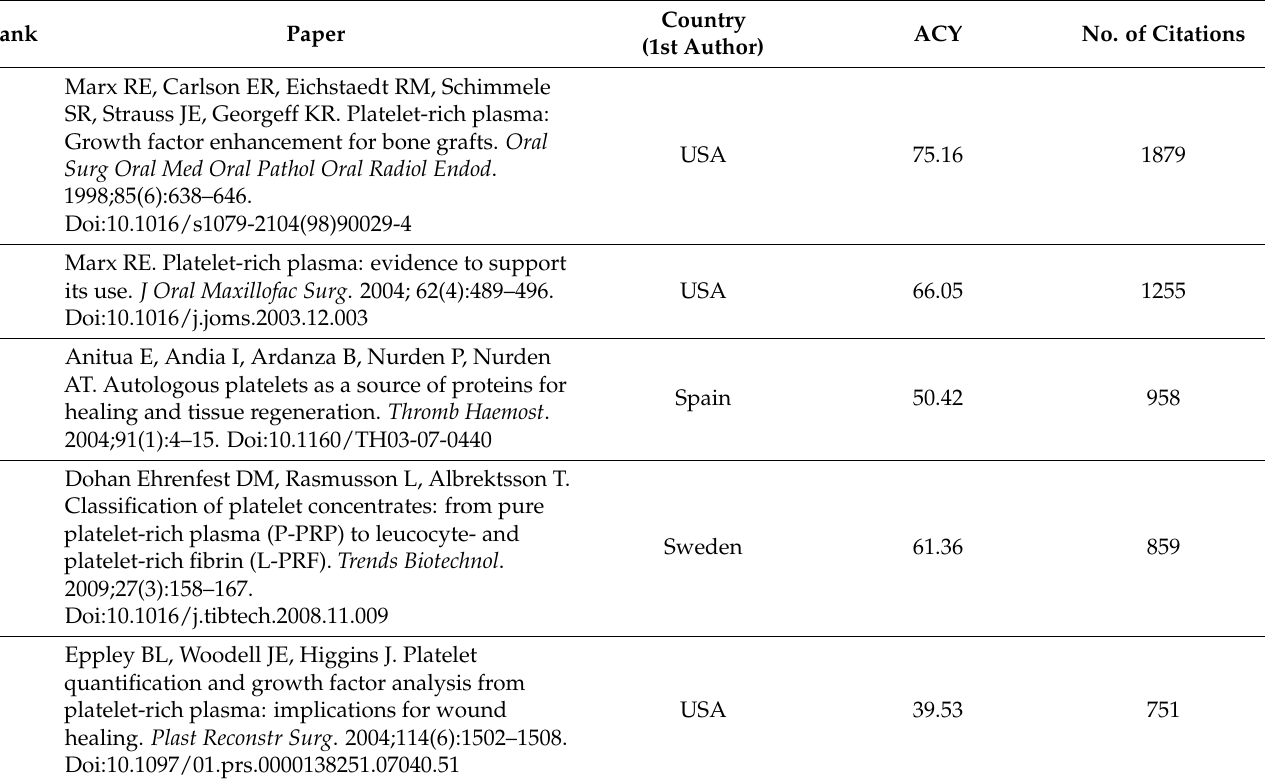
Table A1. List of the 100 most cited articles in platelets-rich plasma use in regenerative